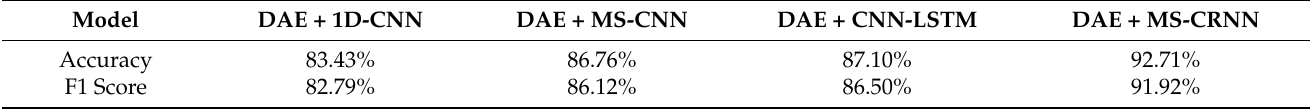
Table 7. Results of the experiment under the denoising condition.